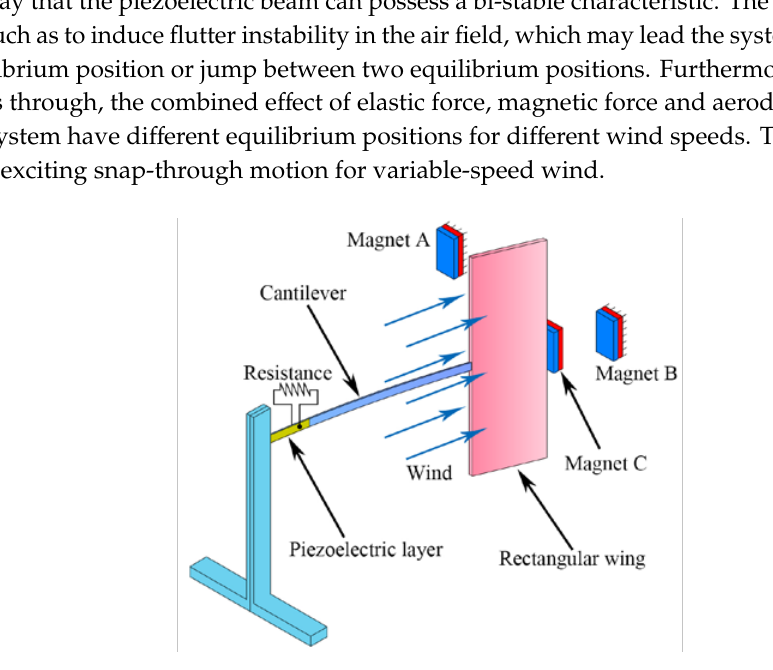
Figure 1. Schematic of the proposed dynamic-stable flutter energy harvester (DFEH).